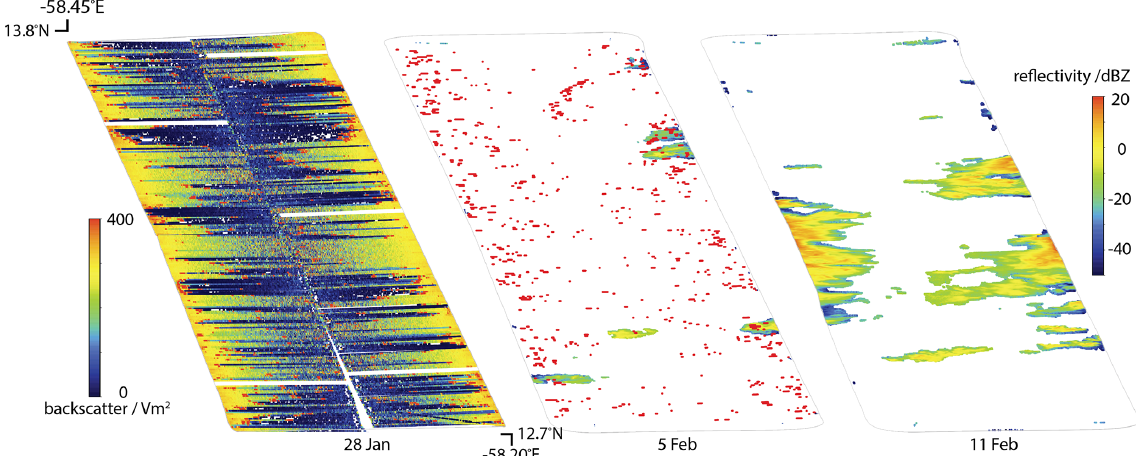
Figure 10. Illustration for January 28 lidar, February 5 lidar and radar, and February 11 radar cloud field observed at cloud base by the ATR with horizontal lidar (detected cloud boundaries denoted by red dots) and radar